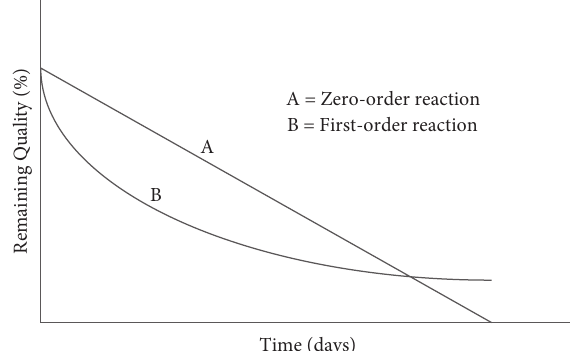
Figure 3: Illustration of product quality